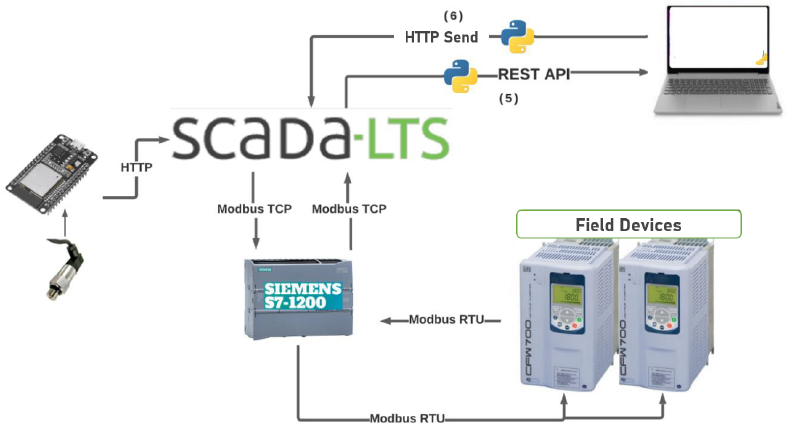
Figure 22. Architecture of the proposed methodology. Source: